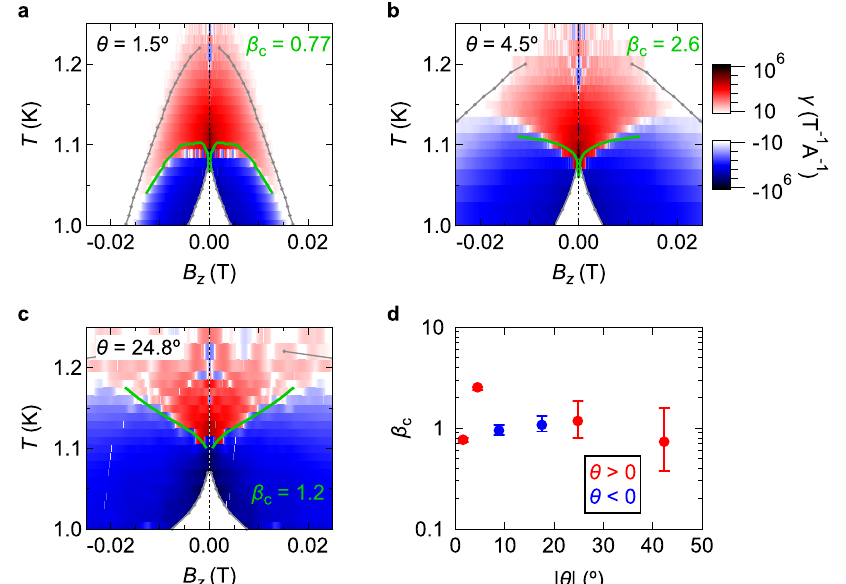
Fig. 4 Sign reversal of the nonreciprocal coef fi cient under various magnetic fi eld tilted angles. a – c Color plots of γ with the contour lines (cid:3) (cid:4) ϕ 0 ¼ 1 þ 1 – T plane for θ = 1.5°, 4.5°, and 24.8°. The value β of R ω β c η (green) in the B z B z j j best fi tting to the boundary between the regions with γ > 0 (red) and γ < 0 (blue). d β c as a function of the tilt angle θ . The data for θ > 0 ( θ < 0) are represented by red